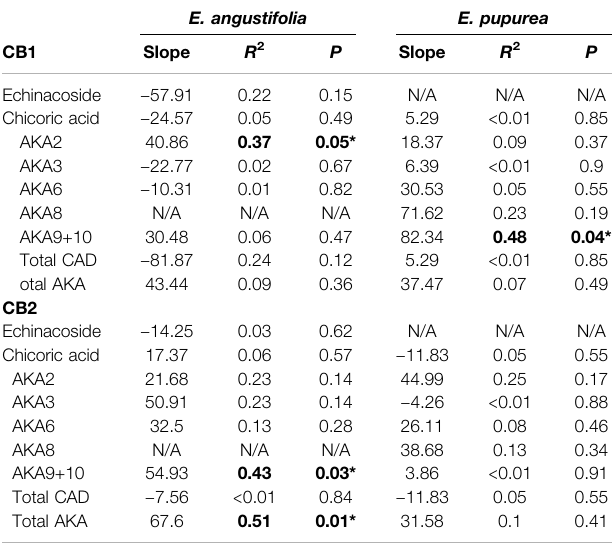
TABLE2| SimplelinearregressionofCB1receptoragonisteffectsasafunctionof log-concentrationofmajorphytochemicalcomponentsofthe11genotypesof E. angustifolia and 9 genotypes of E. purpurea extract. Results are shown for total extract concentration of 0.125 mg/ml for CB1 and 0.625 mg/ml for CB2. CAD, caffeic acid derivatives; AKA,